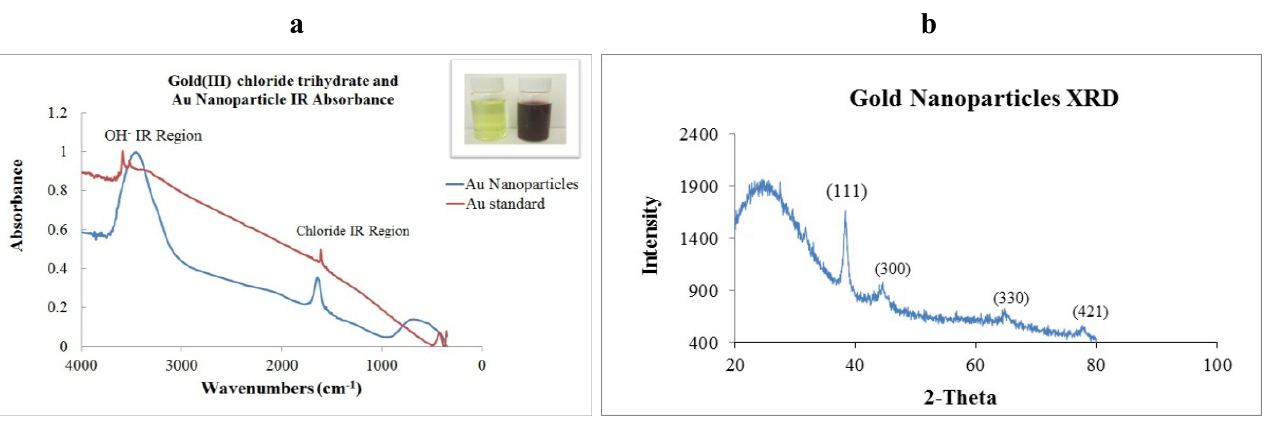
Figure 2. ( a ) Fourier Transform Infrared spectra of colloidal gold (red) and Au-NP (blue) Inset: Photographic image indicating change in coloration. ( b ) X-ray diffraction peaks indicating principal reflections at (111), (300), (330), (421). a